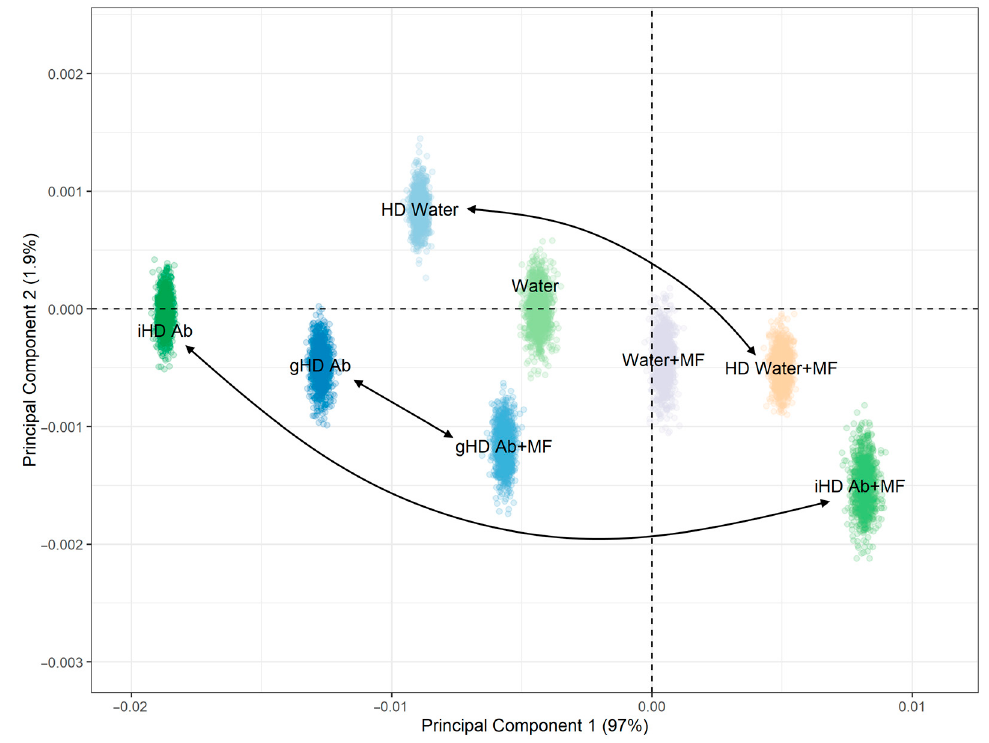
Figure 4. The influence of a magnetic field (+MF) on the distribution of spectra in the wavelength range of 470–2000 cm − 1 in the space of the principal components. Double-sided arrows depict statistically significant differences in the emission spectra between the parenthetical groups ( p < 0.05, comparison of the K-means with the Holm correction).